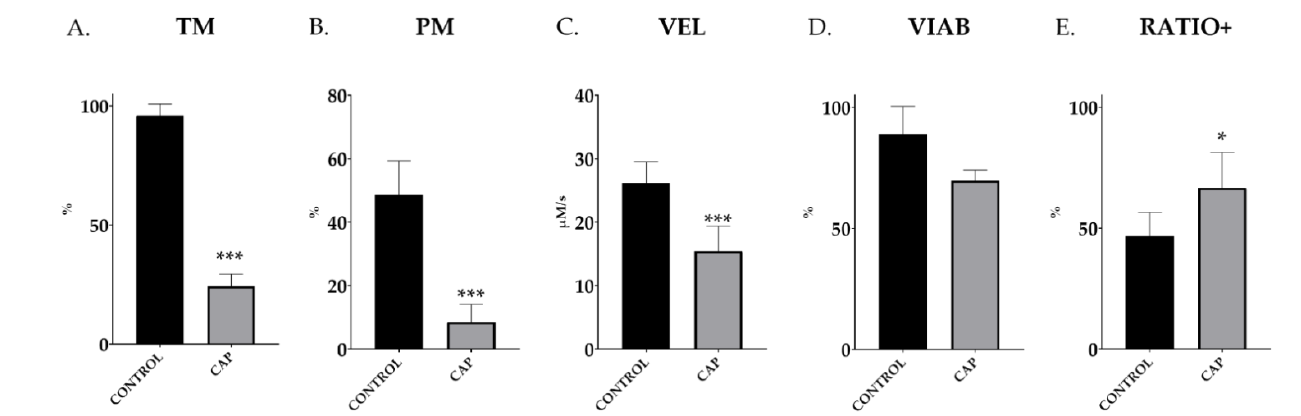
Figure 1. Total motility (TM), progressive motility (PM), velocity (VEL), membrane integrity (VIAB) and ratio of capacitated taking into account only the viable sperm (RATIO+) in control (CONTROL) and in vitro capacitated (CAP) boar ejaculated spermatozoa ( n = 5). The results are shown as mean ± SEM. * depicts significant differences between CONTROL and CAP (* p < 0.05; *** p < 0.001).